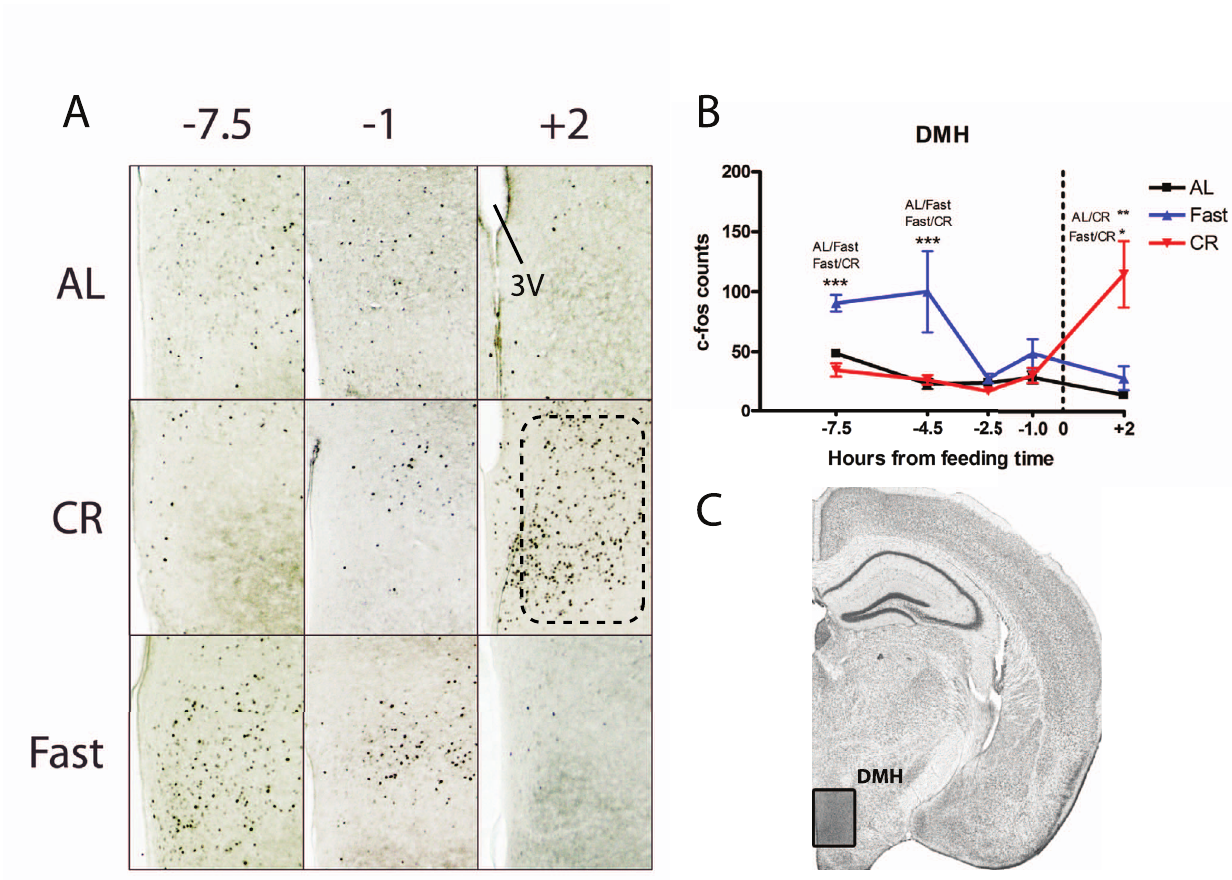
Figure 4. c-Fos protein expression in the dorsomedial hypothalamus of calorie-restricted, acutely fasted, and AL control mice. (A) Representative images of c-Fos staining the DMH of mice at 2 7.5, 2 1 hours before feeding and + 2 hours after feeding. (B) Mean ( 6 SEM) number of c-Fos-immunoreactive nuclei in the DMH of AL controls (blue), fasted (blue), and CR (red) at 5 time points relative to feeding. TP 0 represents time of expected meal presentation as highlighted by the vertical dotted line on the x-axis. (C) Representative coronal brain map with Nissl stain showing location of region under study. (Adapted from Paxinos and Franklin 2007) [57]. Sample sizes for TP 2 7.5 thru + 2 are n=6, 11, 11, 9, 5 for AL groups, n=6, 11, 8, 9, 5 for CR groups, and n=4, 4, 4, 4, 4 for Fasted groups.